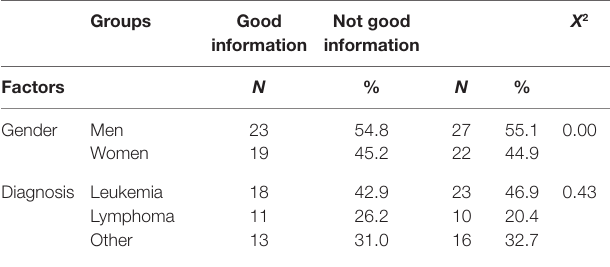
TaBle 2 | information groups by gender and diagnosis ( N =